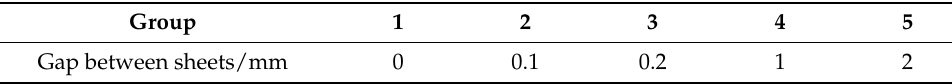
Table 1. Groups of the gap between sheets.